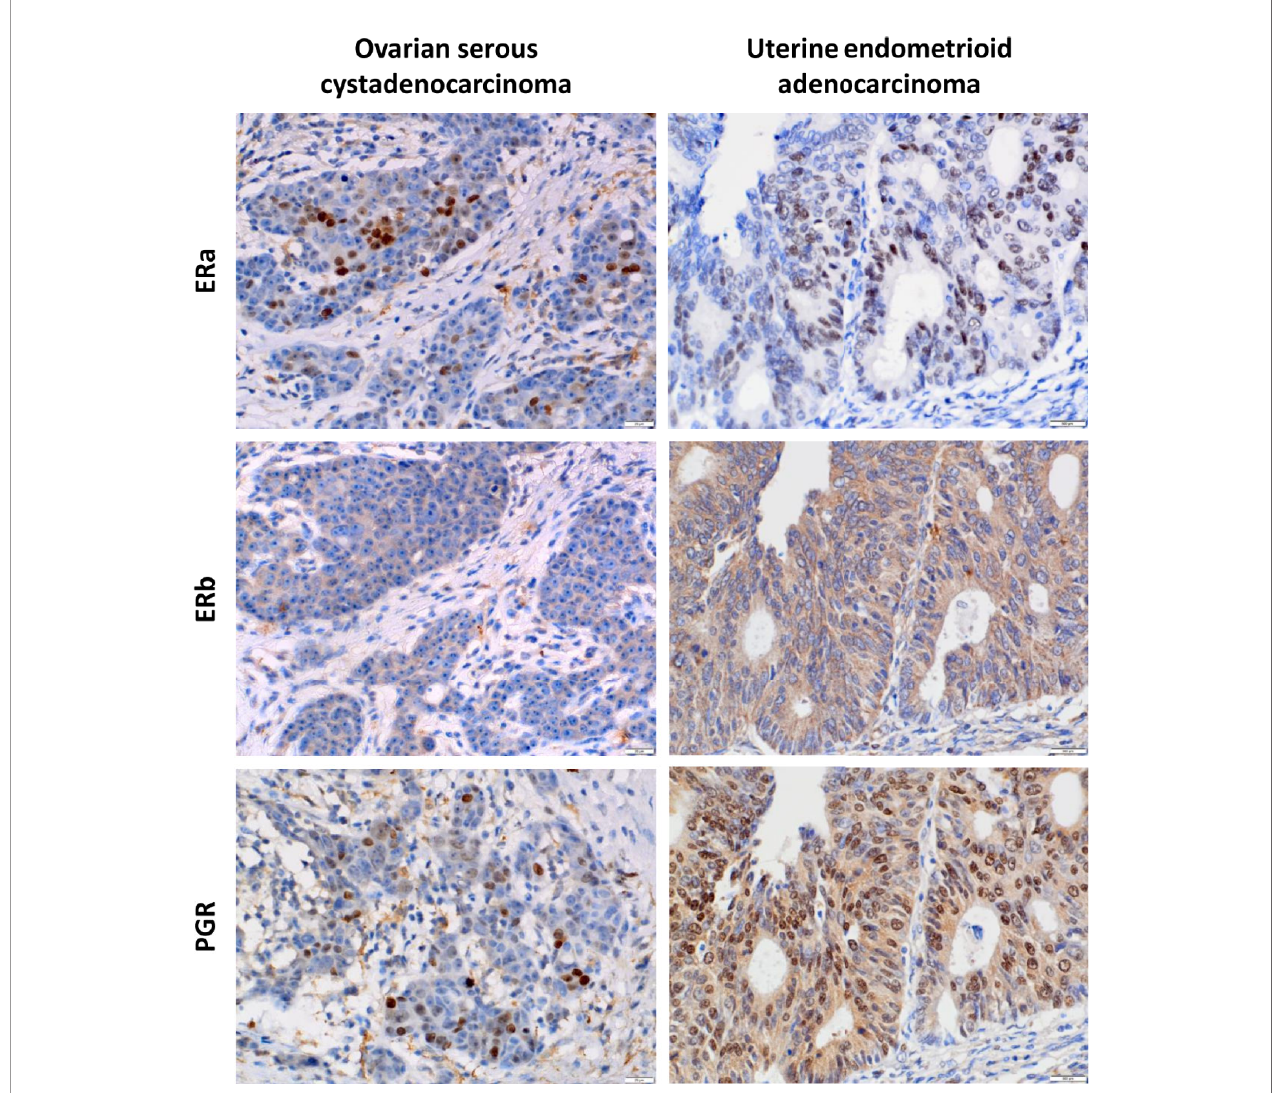
FIGURE 5 | Immunohistochemical analysis of ERa, ERb, and PGR protein expression levels in ovarian serous cystadenocarcinoma and uterine endometrioid adenocarcinoma. Representative immunohistochemical images showed that ERa, ERb, and PGR were differentially expressed in ovarian serous carcinoma and endometrioid adenocarcinoma tissue. Left panels, low expression levels of ERa, ERb, and PGR proteins in serous ovarian carcinoma. Right panels, high expression levels of ERa, ERb, and PGR proteins in endometrioid adenocarcinoma. All micrographs were captured at ×400 magni fi cation.